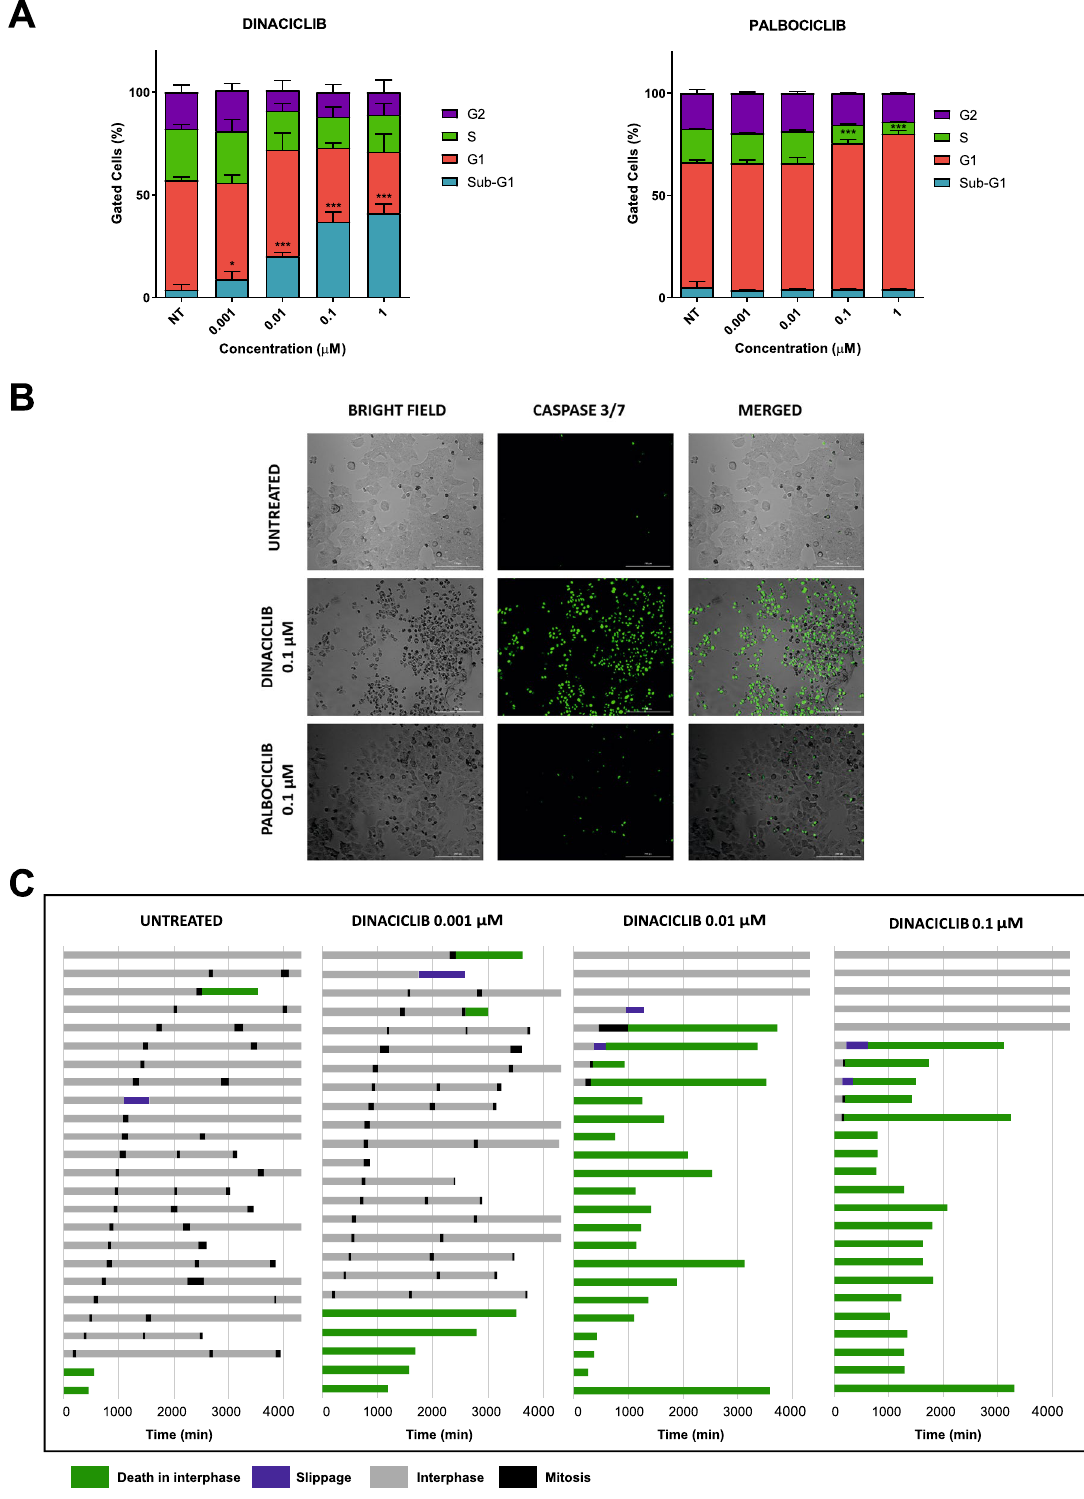
Figure 3. Dinaciclib induces strong cytotoxic effects through apoptosis in medulloblastoma. ( A ) Histogram represents the percentage of HD-MB03 cells arrested in different phases of cell cycle after 24 h treatment with dinaciclib or palbociclib with the indicated doses. ( B ) HD-MB03 cells were treated with indicated drugs for 24 h. CellEvent Caspase 3/7 Green detection reagent was added to live cells and fluorescent signal of apoptotic cells (green) was detected at 100 × total magnification. Representative images are shown. ( C ) Representative cell fate profiles of HD-MB03 cells treated with scalar concentrations of dinaciclib for 72 h. Each line depicts the fate of one single cell followed over time using time-lapse microscopy imaging at 100 × magnification. 0 min is when imaging started. Statistical comparisons were performed using an unpaired, two-tailed Student t-test where * P < 0.05; *** P < 0.001. Plotted graphs show mean ± SD (n =